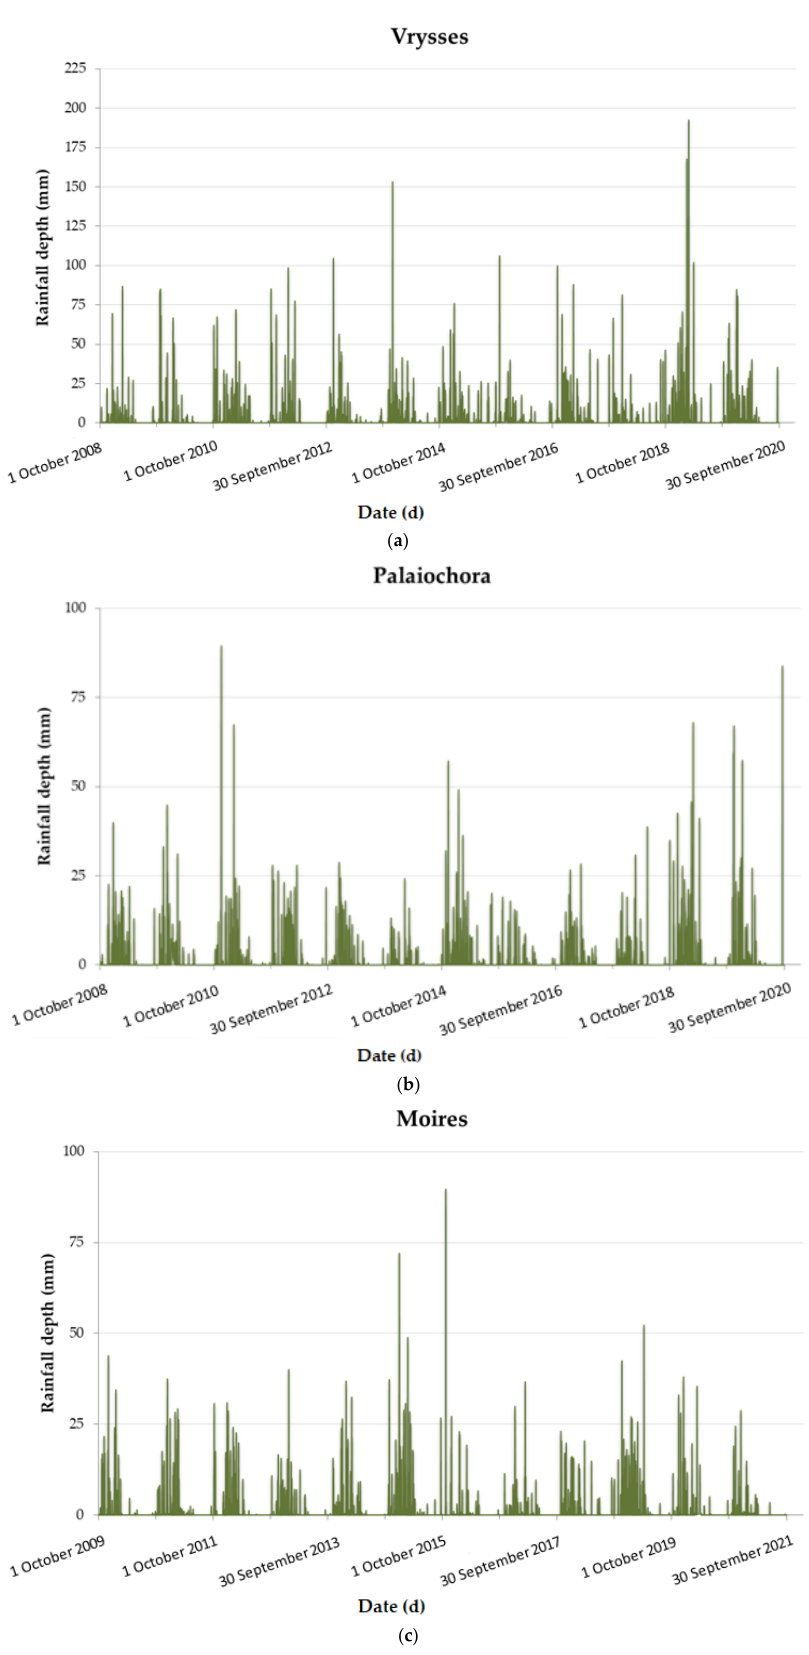
Figure 3. Daily rainfall data for each time period studied at the three stations, Crete, Greece: ( a ) Vrysses, ( b ) Palaiochora and ( c ) Moires.